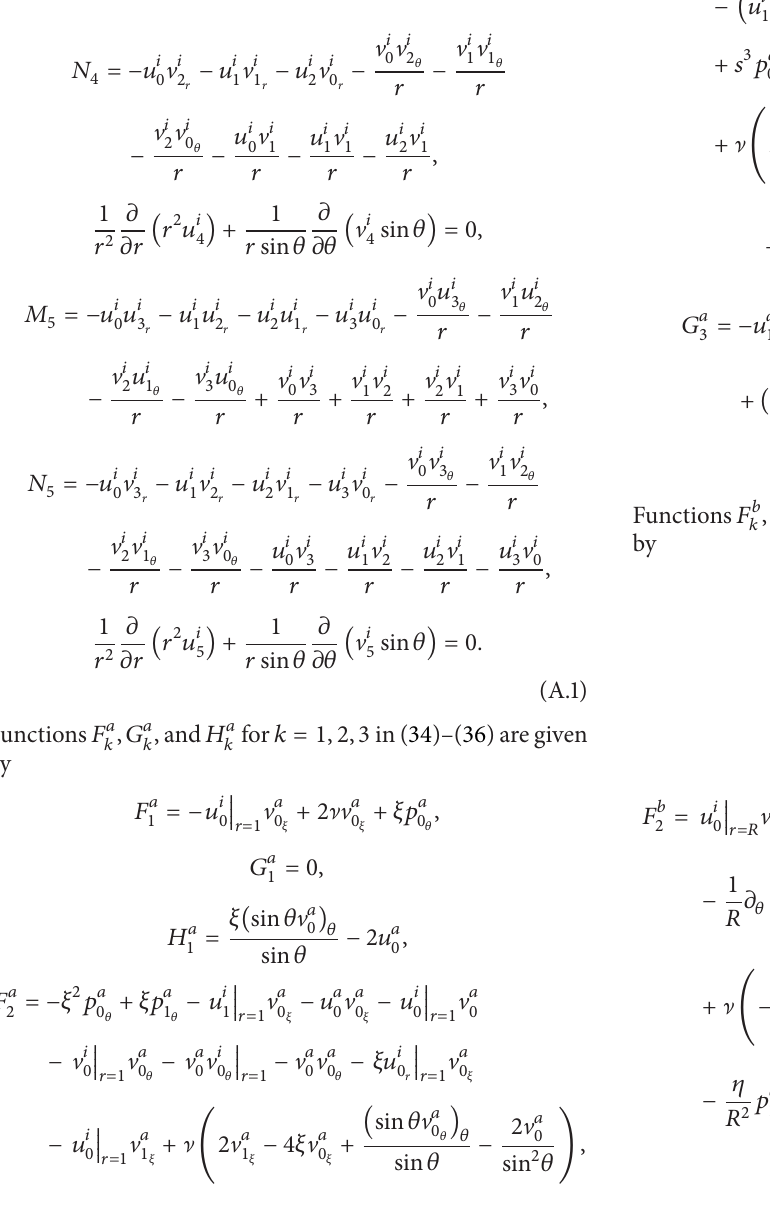
Figure 5: Radial component of the velocity for 𝜖 = 0.316 and 𝑅 = 7